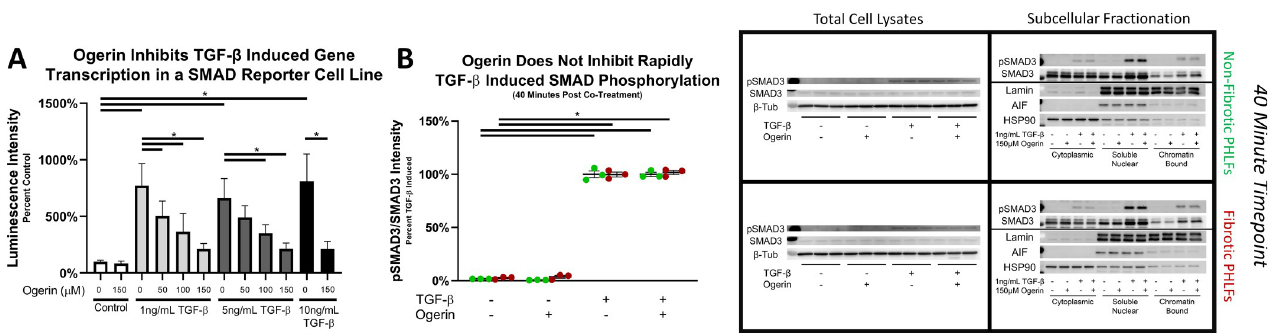
Fig 5. Ogerin inhibits TGF- β induced gene transcription in a SMAD reporter assay. Ogerin does not inhibit TGF- β induced SMAD3 phosphorylation, nuclear localization, or chromatin binding in primary human lung fibroblasts. A: HEK293 cells stably transfected with a TGF- β responsive luciferase element under the transcriptional control of upstream SMAD binding elements co-treated for 24 hours +/- 1-10ng/mL TGF- β and/or +/- 50–150 μ M Ogerin. Cells were lysed with luciferase substrates and measured for luminescence intensity, expressed as a percent of control. n = 8 per treatment group, bars representative of technical replicate average +/- SEM. B: Primary human lung fibroblasts derived from non-fibrotic and IPF patients were co-treated with 1ng/mL TGF- β and/or 150 μ M Ogerin for 40 minutes. Whole cell lysates were analyzed for phosphorylated SMAD3 expression via Western Blot. Phosphorylated SMAD3 band intensity was standardized to total SMAD3 band intensity and expressed as a percent of TGF- β induced. n = 3 per donor per treatment group, dots representative of technical replicates with SEM. Cytoplasmic, soluble nuclear, and chromatin bound subcellular fractionations analyzed for total and phosphorylated SMAD3, and for fractionation efficiency utilizing the same samples on a parallel blot. n = 1 per treatment group per fraction. � = p < 0.05 by One-Way ANOVA with Tukey’s Post-Hoc Test for Multiple Comparisons.